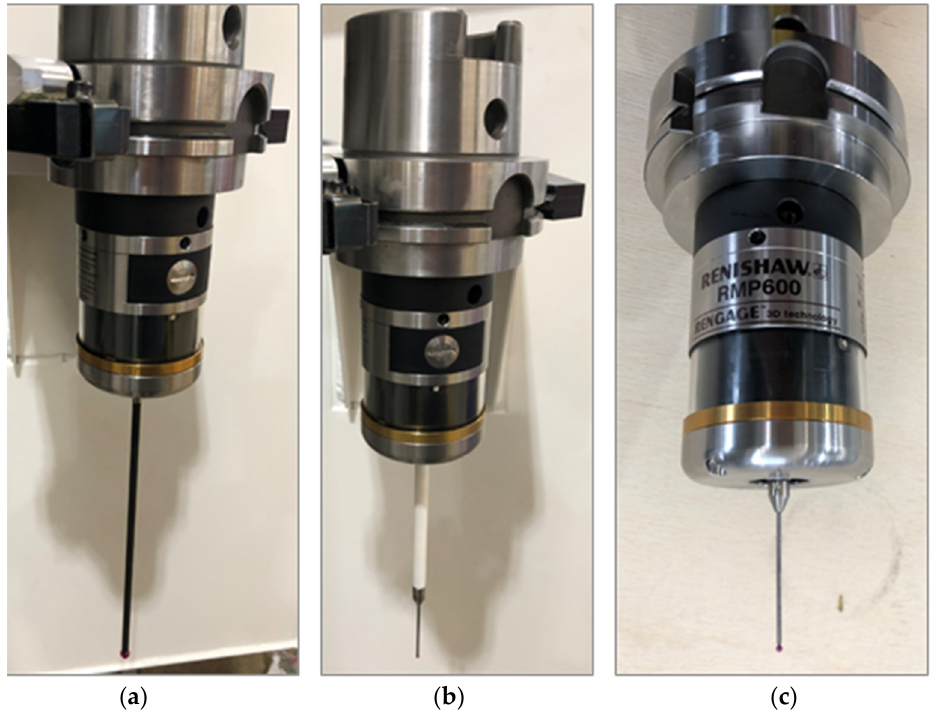
Figure 4. Configuration of RMP600 strain gauge probes with straight stylus shape, various lengths, stylus type, and tip diameter. Detailed data shown in Table 2. ( a ) T1 probe, ( b ) T2 probe, ( c ) T9 probe.